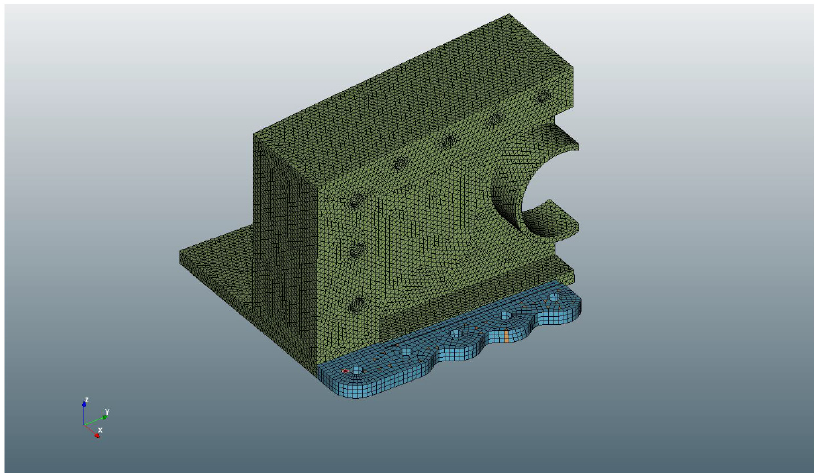
Figure 12. Zencrack wing root model.